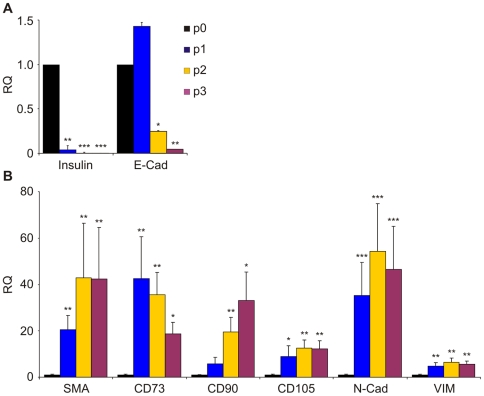
Changes in expression of epithelial and mesenchymal genes in human islet cells during the first 3 weeks in culture.RNA was extracted from cells at the indicated passage number (each passage is equivalent to one week) and analyzed by qRT-PCR. A, analysis of epithelial genes. B, analysis of mesenchymal genes. Data represent relative quantification (RQ) (compared to passage 0) and are mean±SE (n = 6 donors). *p<0.05; ** p<0.005; ***p<0.0005 (compared to passage 0).